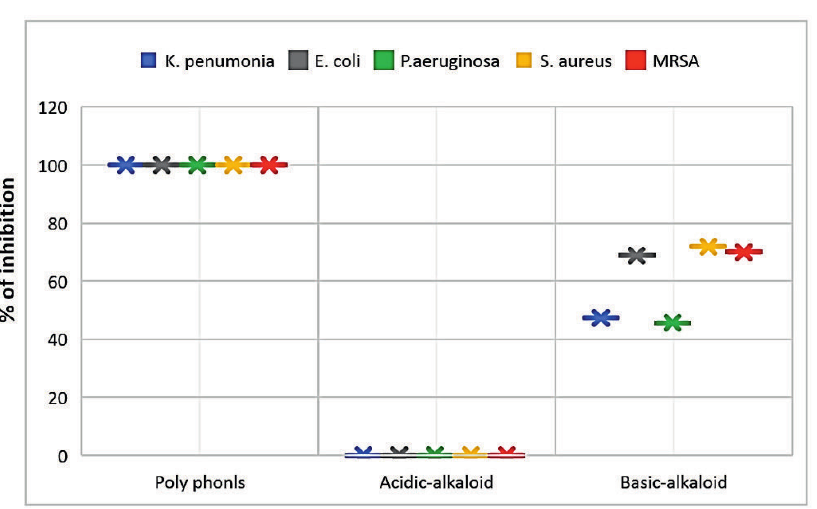
Fig. 3. Antibacterial activities of Acid-Base fractions of Ziziphus spina-christi against tested MDR-bacteria